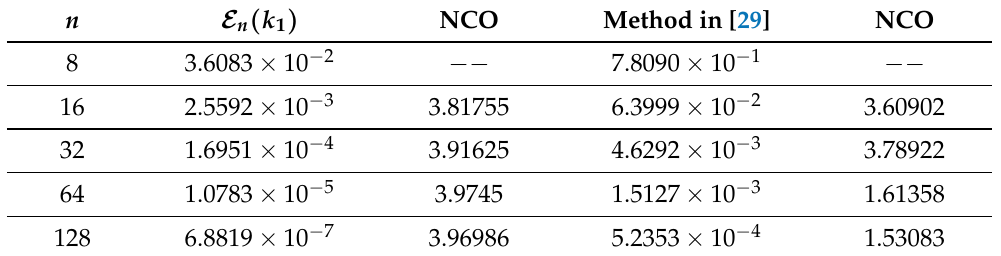
Table 4. Estimated errors for function k 1 , and NCOs with different values of n .